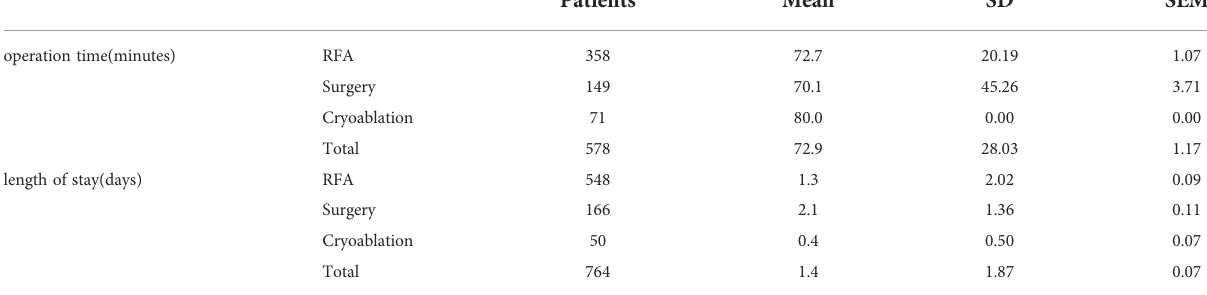
TABLE 5 Mean length of surgery and hospital